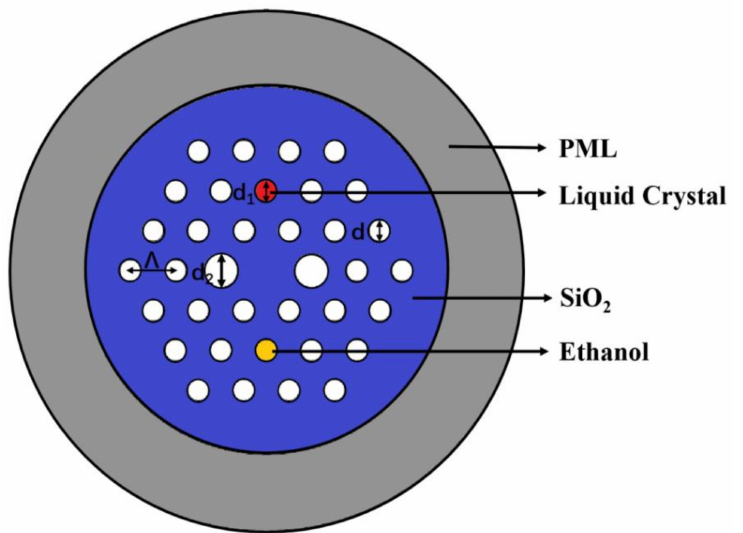
Figure 1. The transverse section of the proposed PCF infiltrated with liquid crystal and